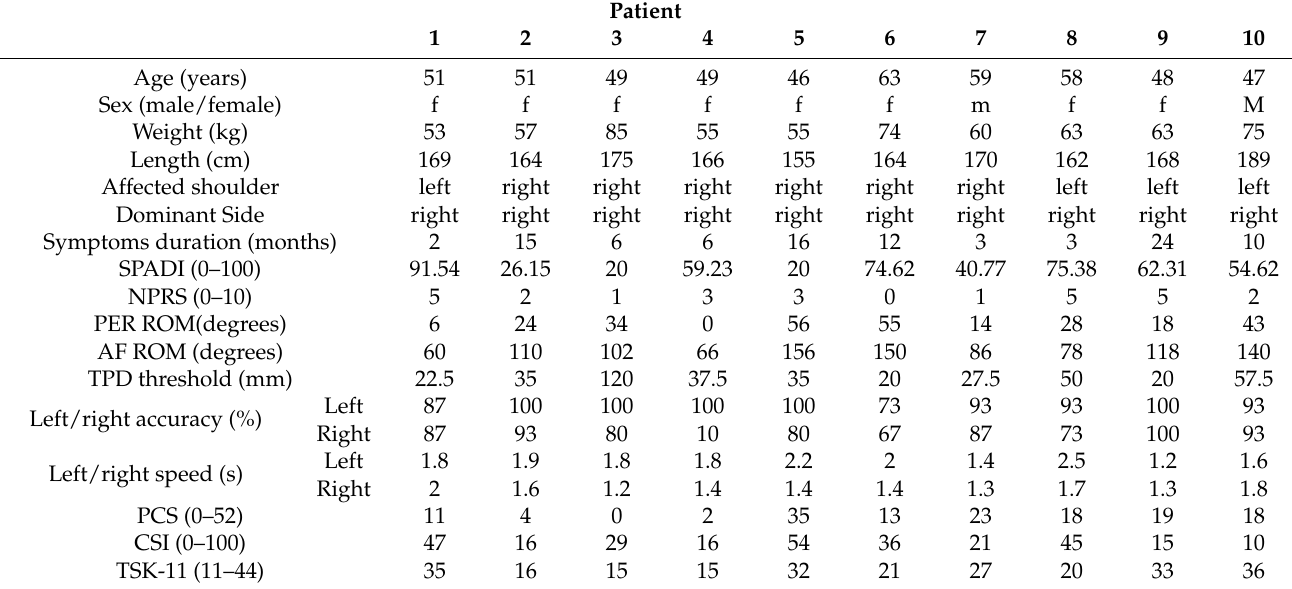
Table 1. Clinical and demographic characteristics of the participants at baseline.